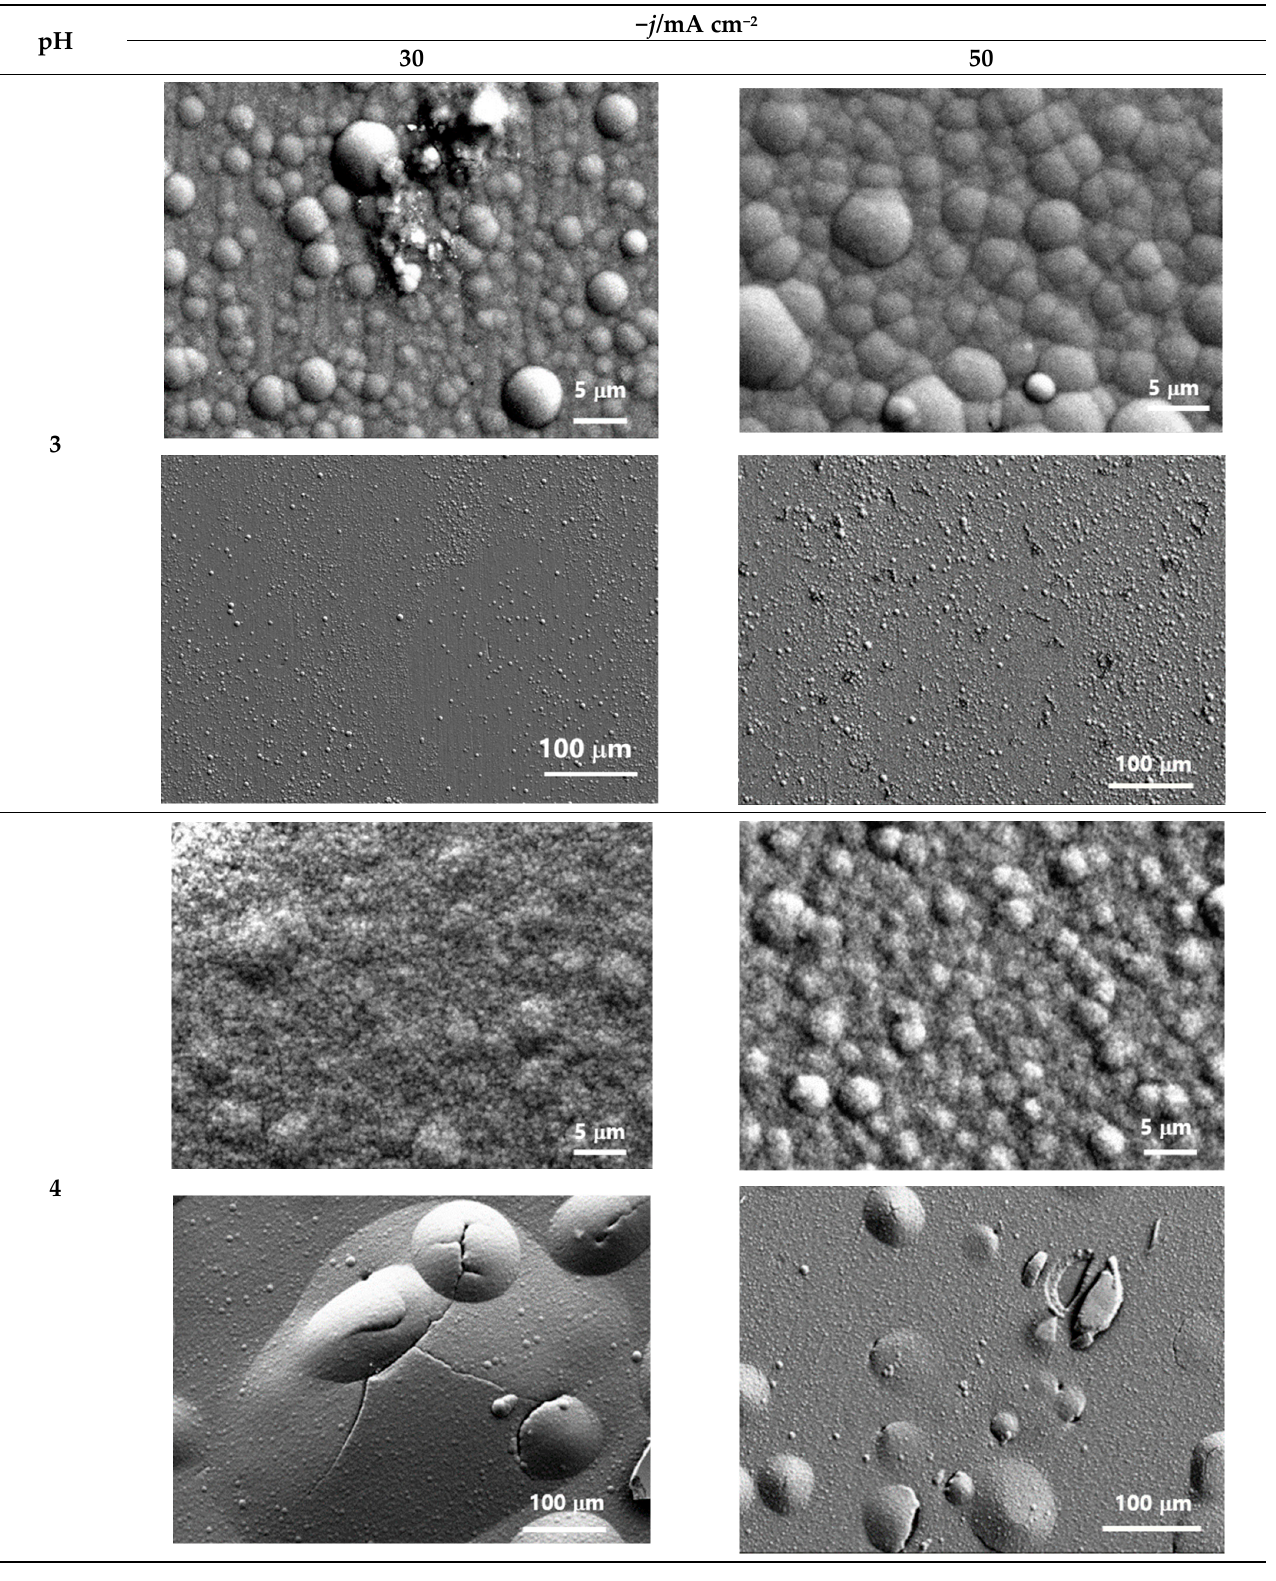
Figure 3. SEM morphology of Fe-W-P coatings deposited with DC electrodeposition at pH 3 and 4, respectively, and current density 30 and 50 mA cm − 2 . Images presented with di ff erent magni fi ca- tions.